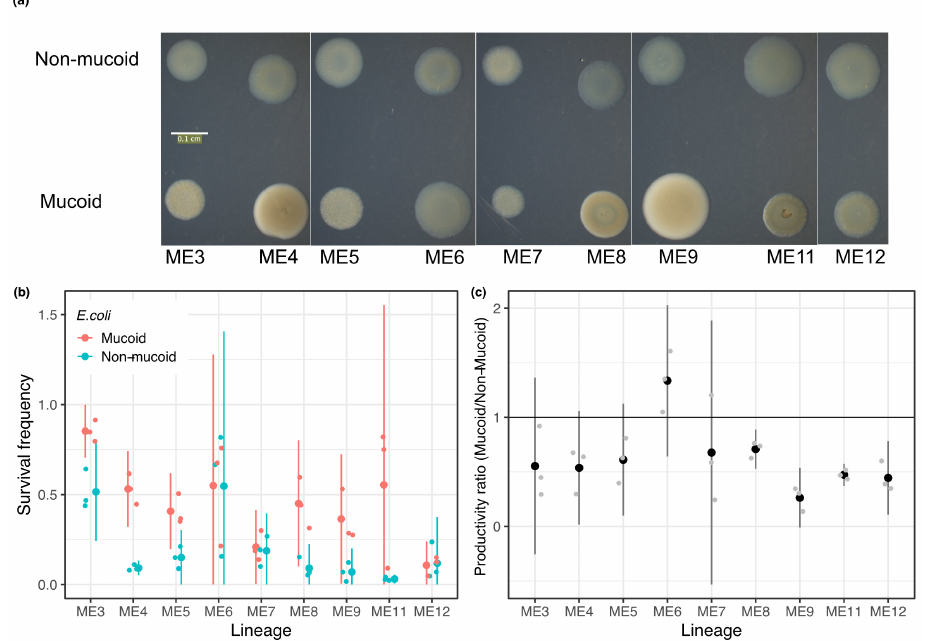
Figure 5. Allopatric variation among mucoid prey. ( a ) Observed mucoid (bottom row) and non- mucoid (top row) colony phenotypes on LB agar for the respective clones isolated from nine coevolv- ing populations at the end of cycle 18 and used in the experiments reported in Figures 3, 4 and 5b,c. Phenotypic differences between the mucoid isolates and between mucoid vs. non-mucoid clones from the same population are yet more pronounced upon direct visual and microscopic observation than in the two-dimensional images shown here. ( b ) Frequencies of prey surviving encounters with M. xanthus are shown. ( c ) The relative productivity (population size after 25 hr) of single mucoid vs non-mucoid clones isolated from nine populations at the end of cycle 18 is shown. A value of 1 (solid black line) indicates equal productivity. ( b , c ) Small dots are values from individual replicates and